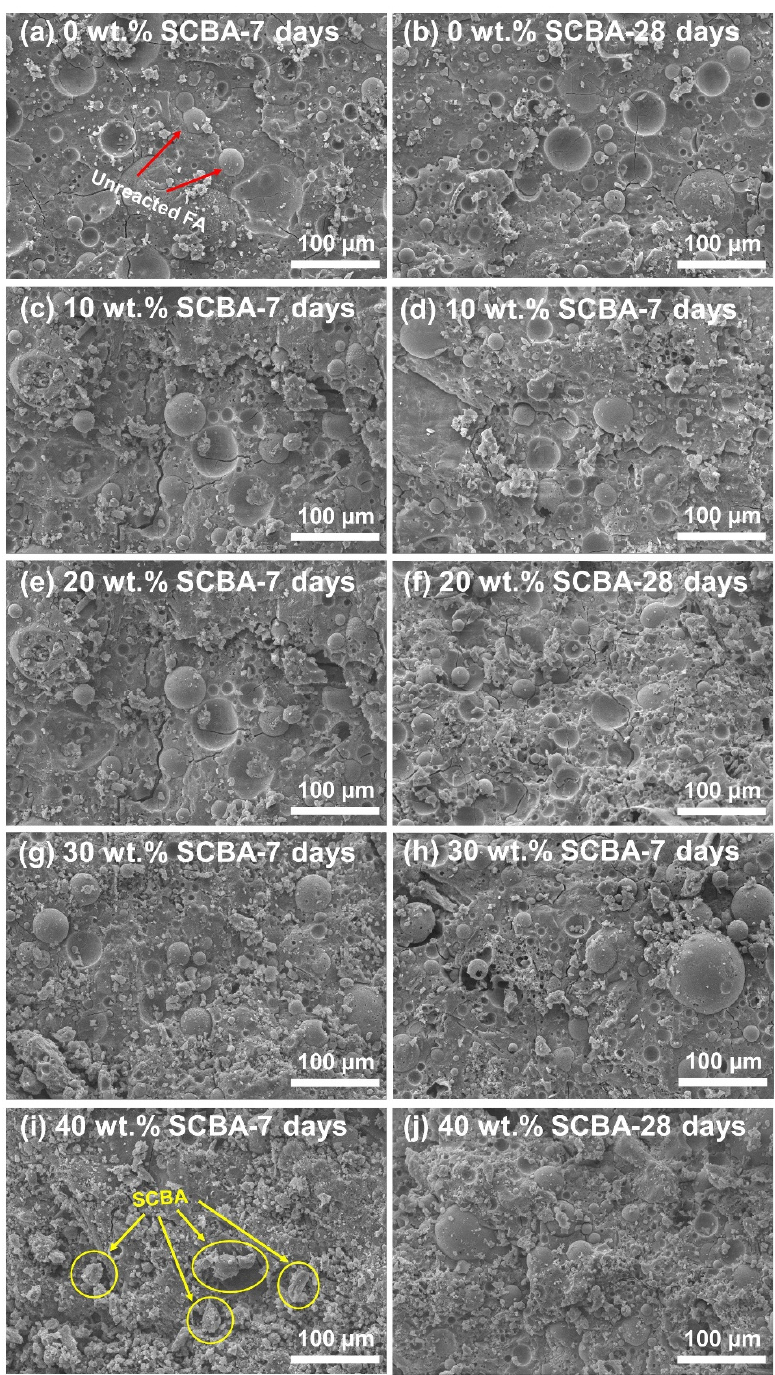
Figure 6. SEM micrographs of the geopolymer pastes at 7 and 28 days with SCBA of ( a , b ) 0 wt.%, ( c , d ) 10 wt.%, ( e , f ) 20 wt.%, ( g , h ) 30 wt.%, and ( i , j ) 40 wt.%.